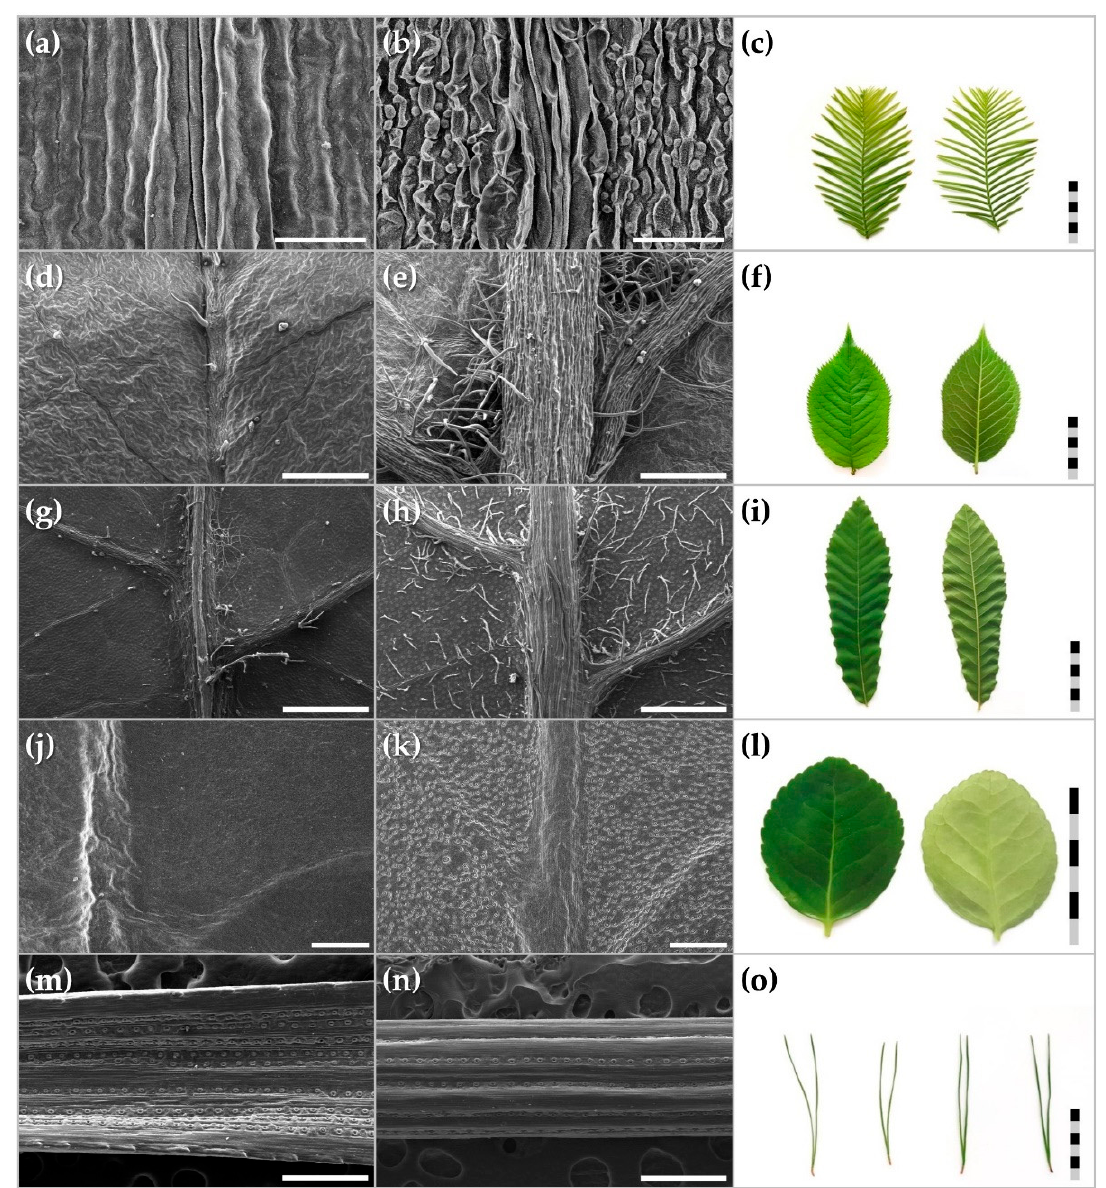
Figure 4. Representative micromorphological and leaf morphological variations on adaxial ( a , d , g , j , m ) and abaxial ( b , e , h , k , n ) leaf surfaces of ( a – c ) M. glyptostroboides , ( d – f ) P. yedoensis , ( g – i ) Q. acutissima , ( j – l ) E. japonicus , and ( m – o ) P. densiflora . Scale bars: ( d , e , g , h , j , k , m , n ) 500 µm; ( a , b ) 100 µm; ( c , f , i , l , o ) 5 cm.